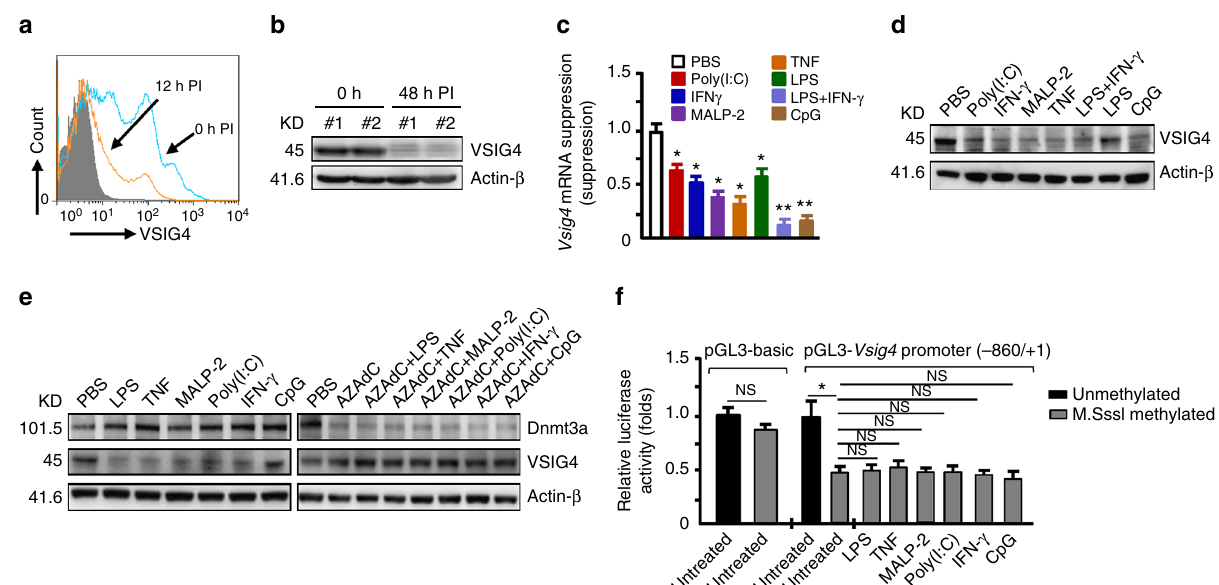
Fig. 7 Vsig4 gene transcription is repressed Dnmt3a-mediated DNA methylation. The C57BL/6 WT mice were infected with MHV-3 (100 PFU/mouse), a the expression of VSIG4 on PEMs at 0 h and 12 h PI was detected by fl ow cytometry. b VSIG4 protein level in liver tissues was analyzed by western blot. The BMDMs were treated with proin fl ammatory factors for 12 h. c Vsig4 gene transcription was detected by qRT-PCR. d VSIG4 protein expression was evaluated by western blot. e The BMDMs were treated with Dnmts inhibitor-AZAdC (10 μ M) for 72 h in advance, cells were then further added with proin fl ammatory mediators for 12 h, the expression of Dnmt3a and VSIG4 was assessed by western blotting. f Luciferase activity of the lysates from RAW264.7 cells transfected with unmethylated or M.SssI methylated pGL3-basic vector and the -840/+1 Vsig4 promoter constructs. Error bar, s.e.m. * p < 0.05, ** p < 0.01 and NS, p > 0.05 (Student ’ s t -test). Data are representative of three independent